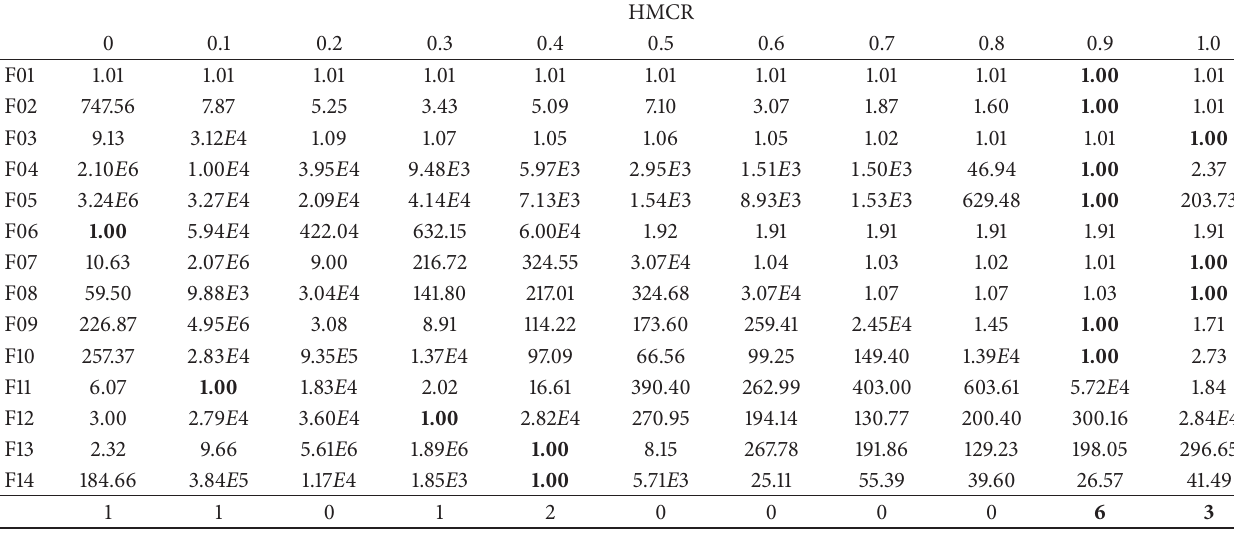
Table 10: Mean normalized optimization results in fourteen benchmark functions with different HMCR. The numbers shown are the best results found after 100 Monte Carlo simulations of HS/BA algorithm.